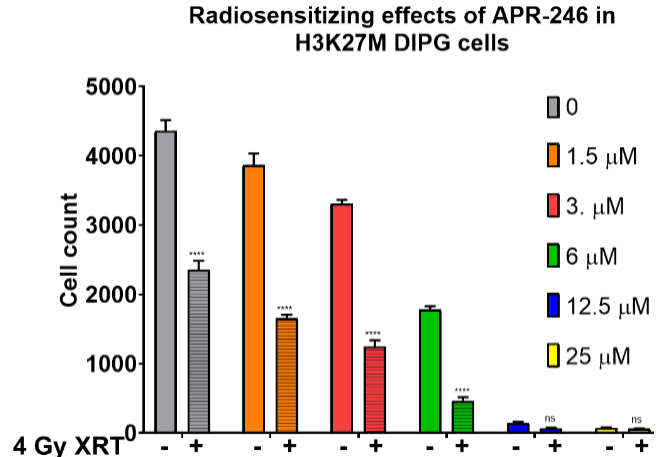
Figure 1. Anti-proliferative and radio-sensitizing effects of APR-246 in H3K27M DIPG cells. Proliferation assay with SF8628 pediatric diffuse intrinsic pontine glioma (DIPG) cell line harboring the histone H3.3 K27M mutation. The growth inhibitory and radiosensitizing effects of APR-246, by comparing the cell counts with 4 Gy dose (+) of radiation (crossed bars), versus without (−) radiation treatment (open bars). The cells were treated with the indicated concentrations of APR-246 for 6 h, then subjected to 4 Gy dose of radiation (or mock-treated). Ninety-six hours post-treatments, the cell counts were determined and plotted along the Y-axis. **** = p < 0.0001. ns = not statistically significant.